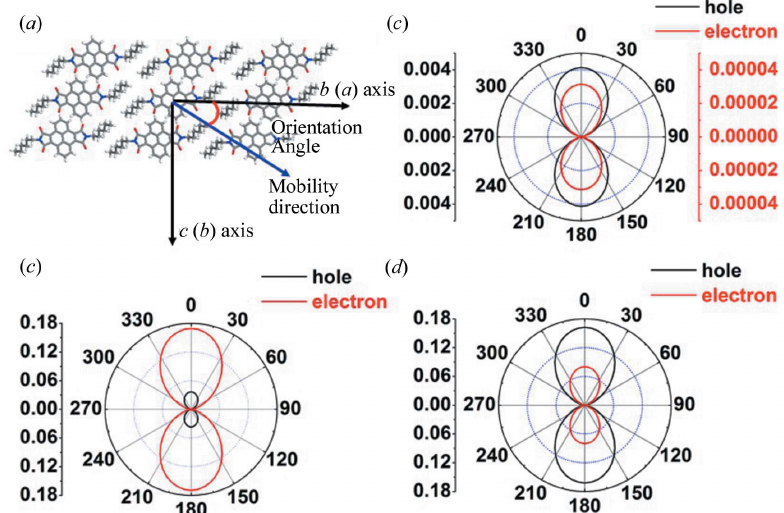
Figure 4 ( a ) Illustration of the orientation angle of the transistor channel relative to the crystallographic b axis for C 5 -PyDI and C 6 -PyDI and the orientation angle of the transistor channel relative to the crystallographic a axis for t -C 5 -PyDI. Calculated angle-resolved anisotropic hole (black line) and electron (red line) transport mobility as a function of orientation angle for ( b ) t -C 5 -PyDI, ( c ) C 6 -PyDI and ( d ) C 5 -PyDI.